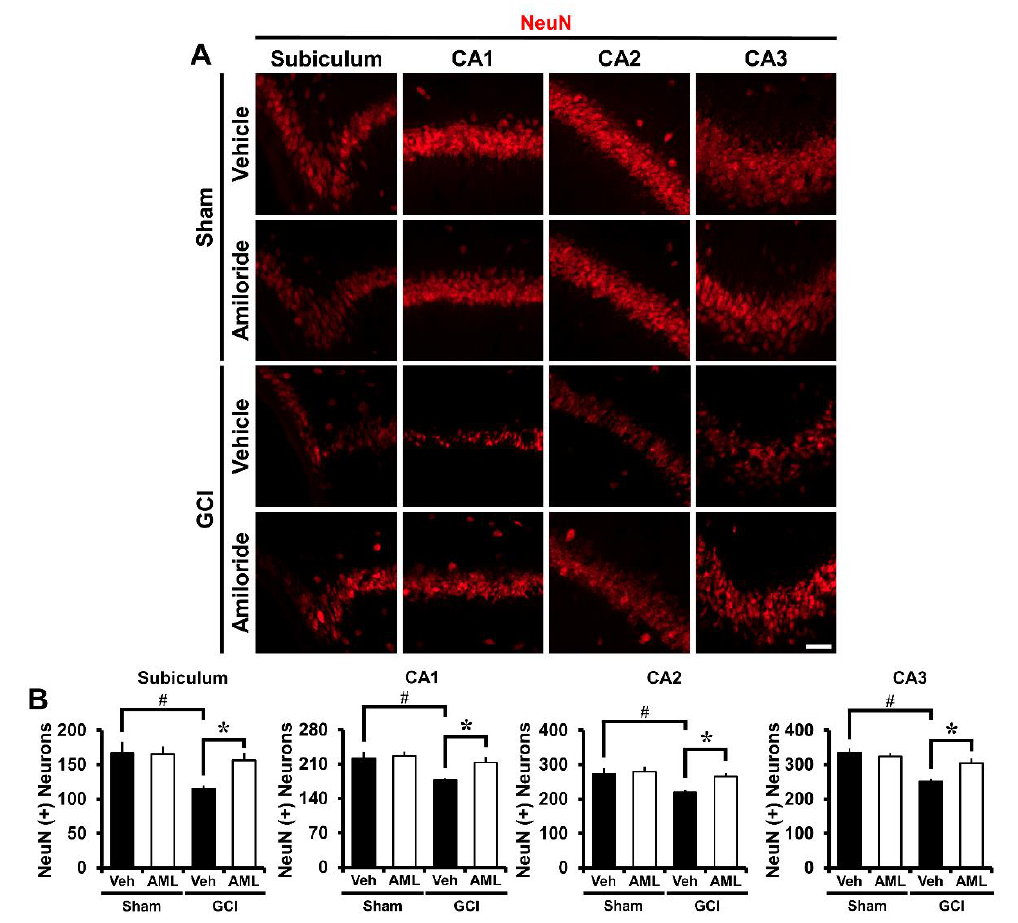
Figure 6. Amiloride treatment improves neuronal survival after GCI. The presence of live neurons after ischemic insult was confirmed in the Sub, CA1, CA2, and CA3 regions. ( A ) Fluorescent images show surviving neurons in the Sub, CA1, CA2, and CA3 regions. Intraperitoneal post-treatment with amiloride (10 mg / kg) increased the number of live neurons in the Sub, CA1, CA2, and CA3 regions at 3 days post-ischemia. Scale bar = 20 µ m. ( B ) Bar graph displaying the quantification of surviving neurons in hippocampal subregions. The number of NeuN ( + ) neurons was increased in the amiloride-injected (10 mg / kg) group in the Sub, CA1, CA2, and CA3 regions compared with the vehicle-treated group (GCI-vehicle, n = 8; GCI-amiloride, n = 6). Data are mean ± SEM. * Considerably di ff erent from the vehicle-treated group, p < 0.05; # sham versus vehicle-operated group, p < 0.05. (Kruskal–Wallis test (B) Sub: Chi square = 14.214, df = 3, p = 0.003; CA1: Chi square = 13.422, df = 3, p = 0.004; CA2: Chi square = 14.249, df = 3, p = 0.003; CA3: Chi square = 16.158, df = 3, p = 0.001).